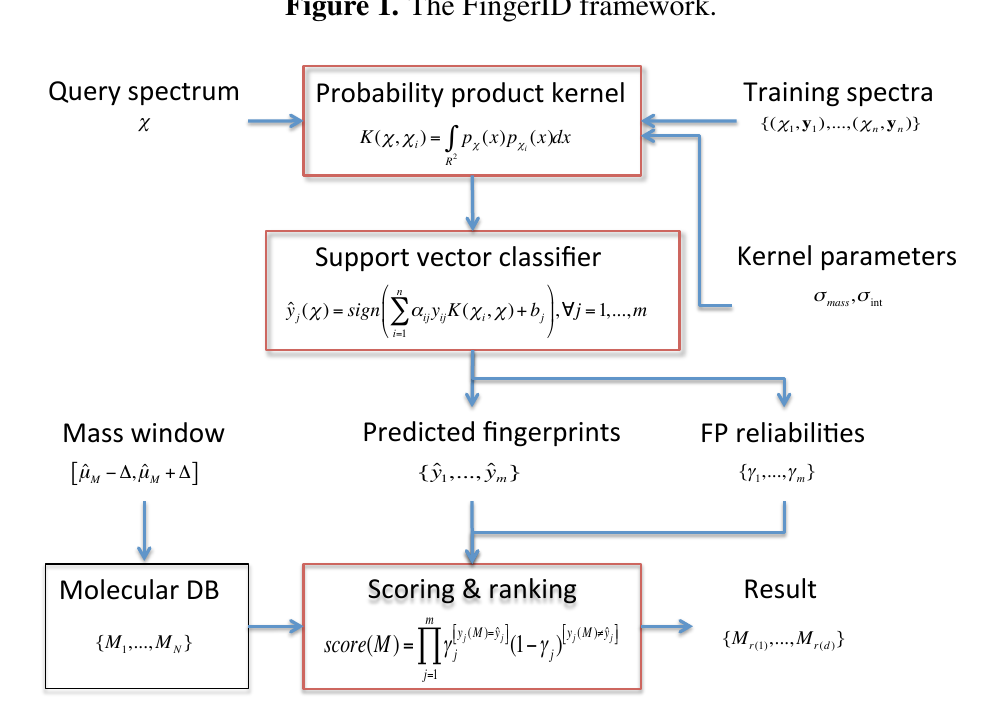
Figure 1. The FingerID